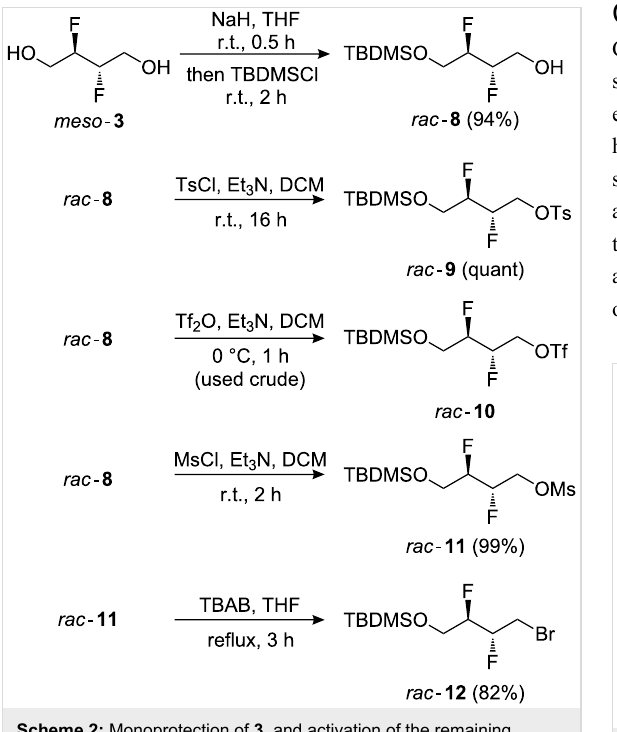
Scheme 2: Monoprotection of 3 , and activation of the remaining alcohol. Figure 2: Molecular overlay of both conformers of 7